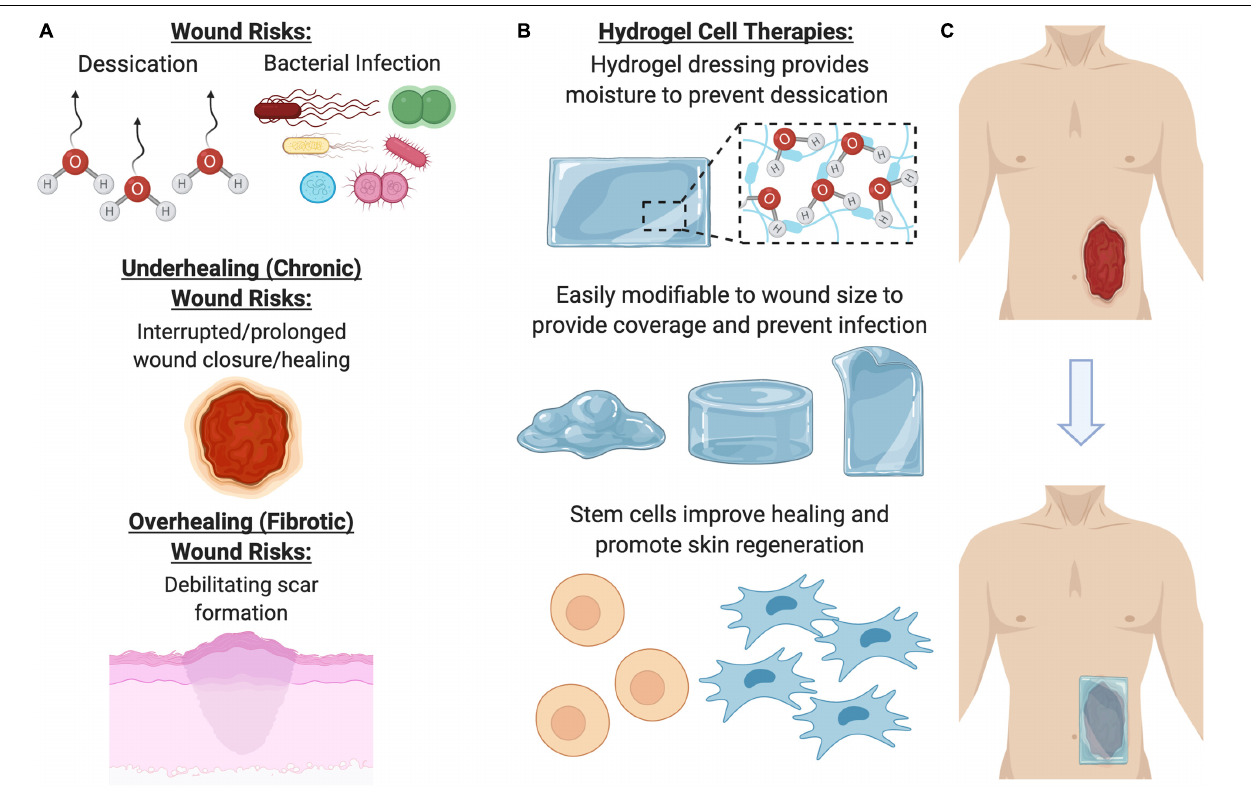
FIGURE 4 | Benefits of using a hydrogel dressing to deliver cellular therapies. (A) Open wounds are at risk for desiccation (loss of moisture) and bacterial infection, as well either underhealing or overhealing. (B) To address these major risk factors, hydrogel dressings provide coverage and moisture, as well as a beneficial ECM environment for cells to grow in. (C) Once the hydrogel has been seeded with cells, it can be laid on the wound to promote healing and